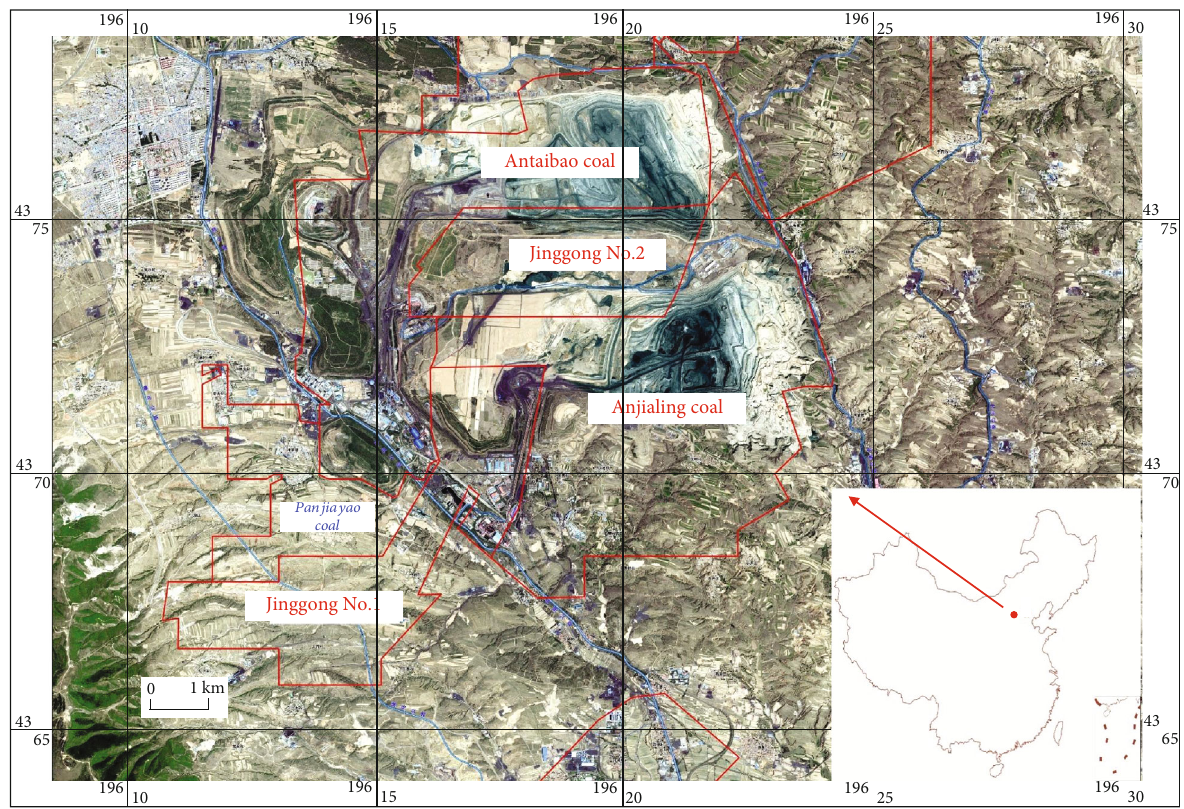
Figure 1: Location of the research